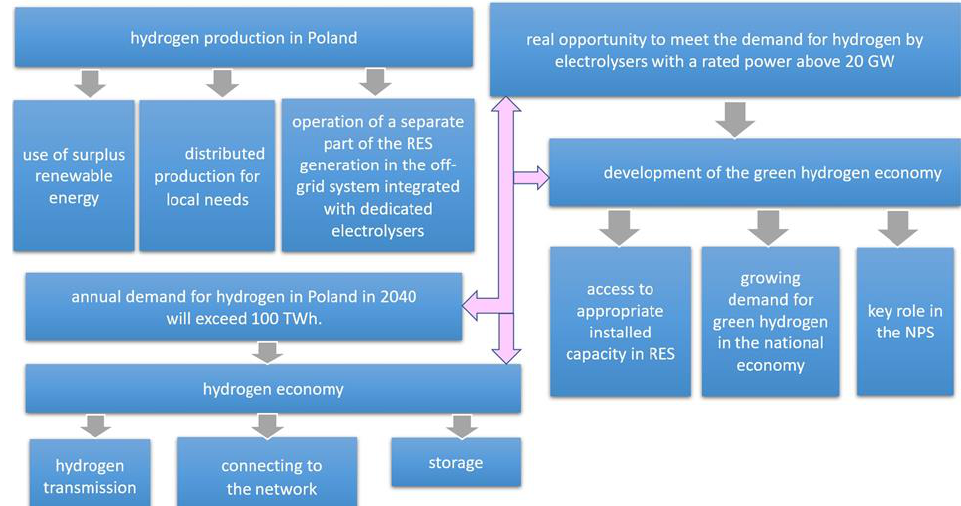
Figure 9. Hydrogen production in Poland [61].